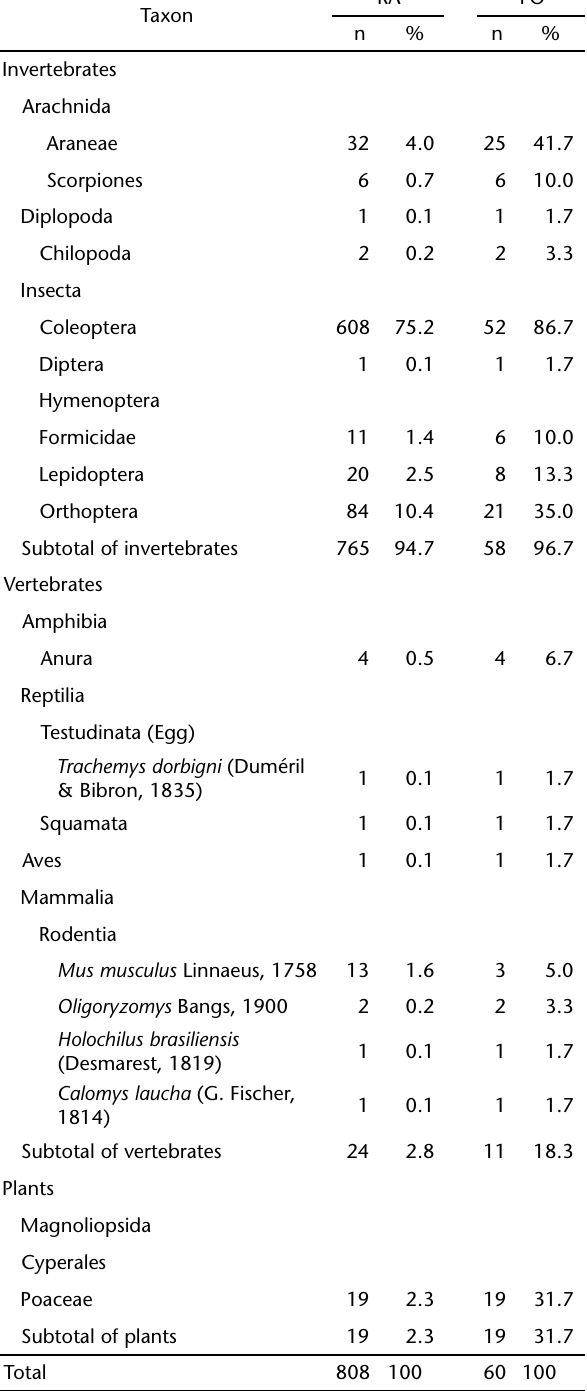
Table I. Food items used by C. chinga in the extreme south of Brazil. Relative abundance (RA) and frequency of occurrence (FO) of prey items in 60 stomachs (n: numbers of itens; %: